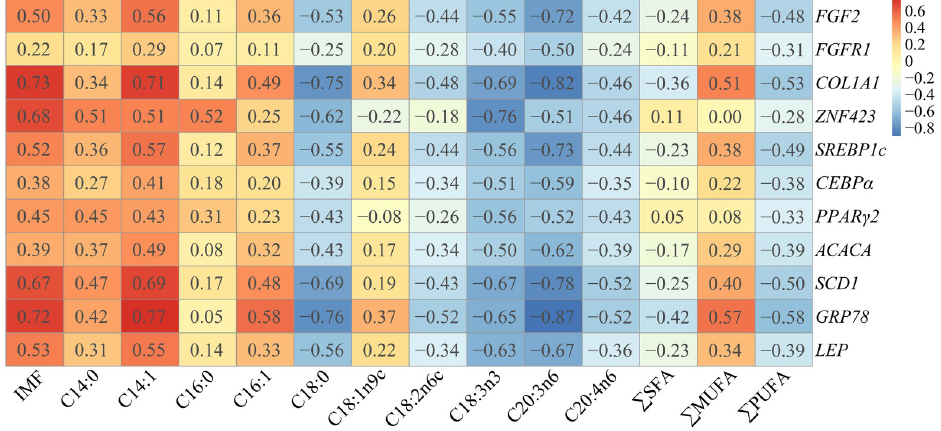
Fig 4. Correlations among gene expression levels, IMF content and fatty acid composition in the LM. The number in each cell represents the correlation coefficient.